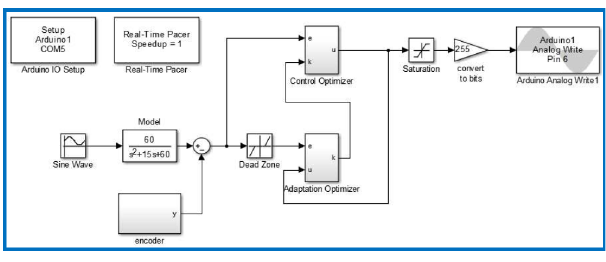
Fig 13. Matlab/Simulink design of the proposed adaptive control system.